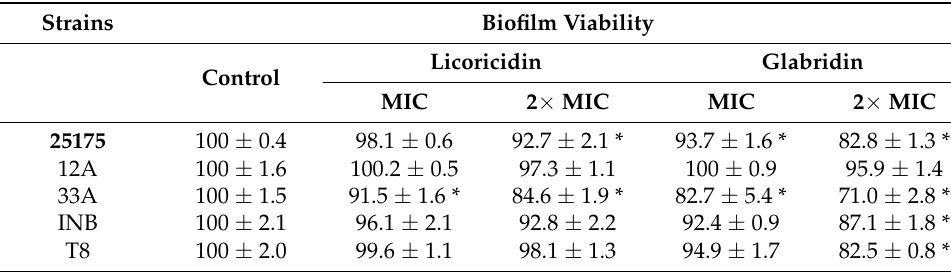
Table 2. Effect of licoricidin and glabridin on the viability of preformed Streptococcus mutans biofilms following a 2-h treatment. The assays were carried out in triplicate, and the means ± standard deviations were calculated. *, significantly different ( p < 0.001) from the control.